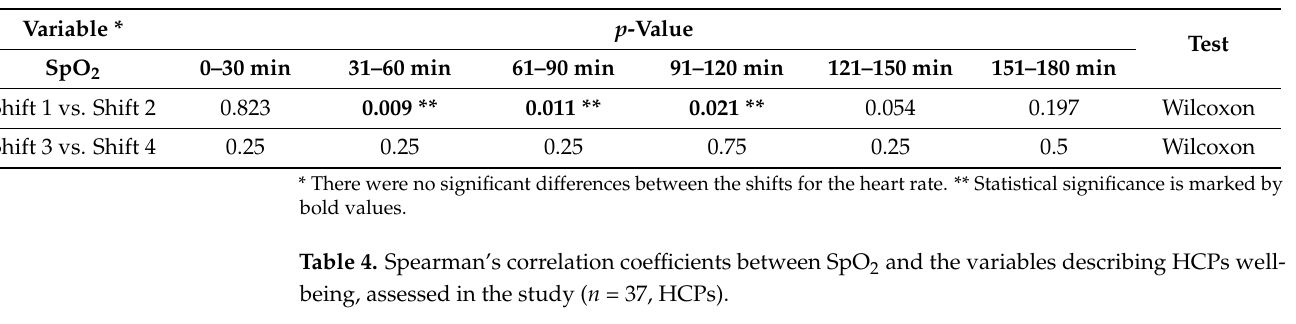
Table 3. Comparison of differences ( p -value) between shifts 1 and 2 and between shifts 3 and 4. SpO 2 results in 30-min intervals for each participant’s SpO 2 mean level calculation.